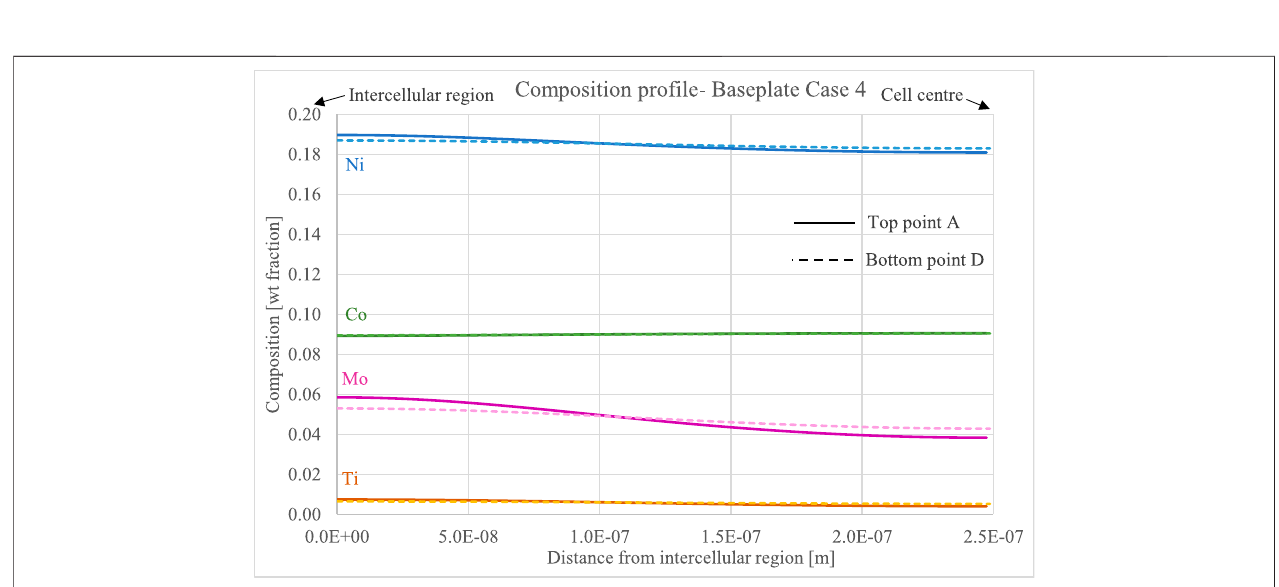
FIGURE 12 | Calculated composition pro fi le for point A for Cases 1, 4, and 5. Cell center is at the right side and interdendritic/intercellular region to the left.